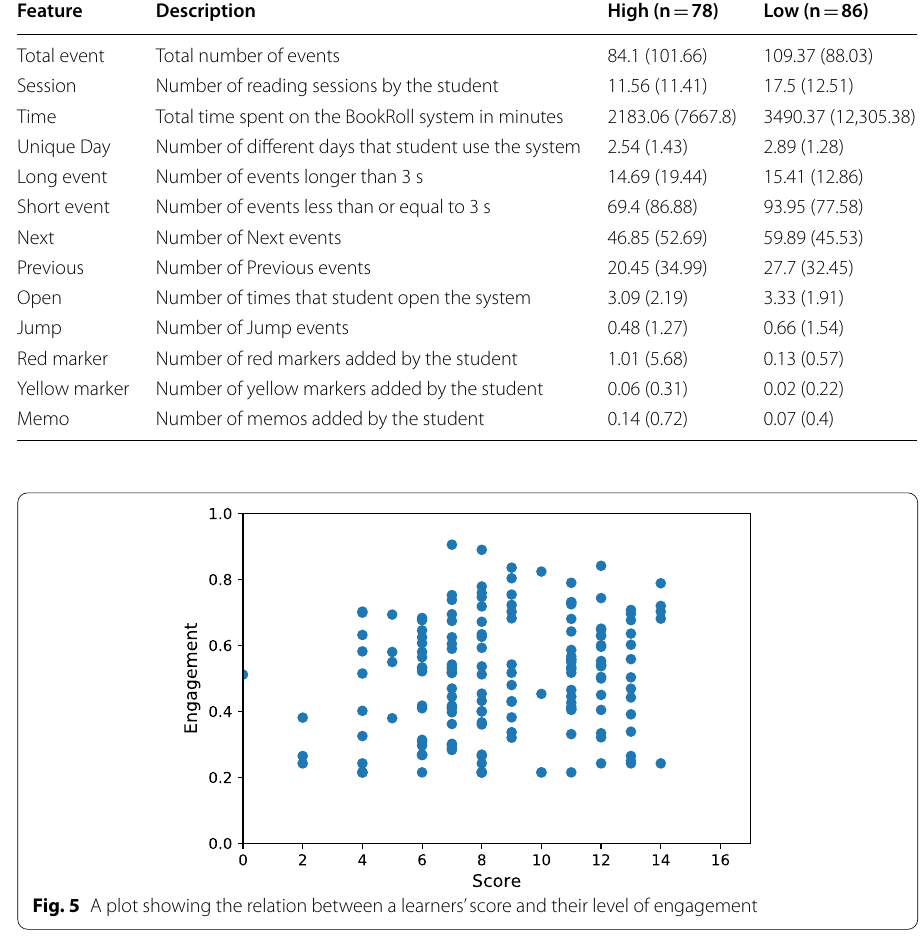
Table 4 Description of features for calculating engagement